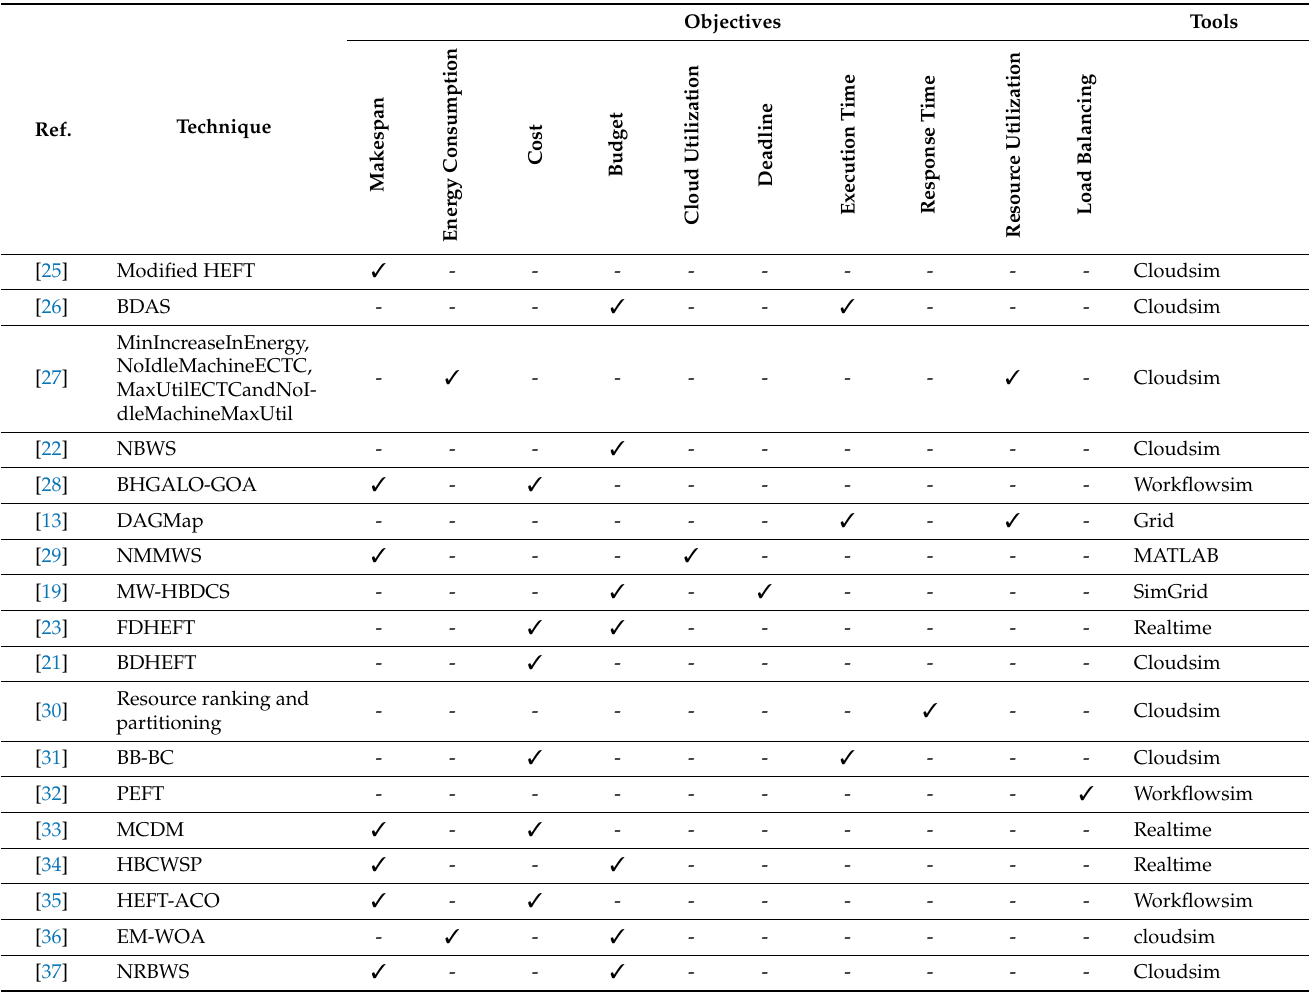
Table 1. Summary of workflow scheduling algorithms for cloud